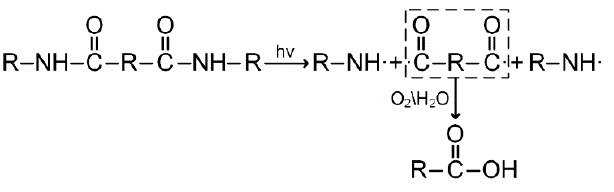
Figure 17. Schematic of the molecular chain scission. The ‘R’ is arbitrary organic.